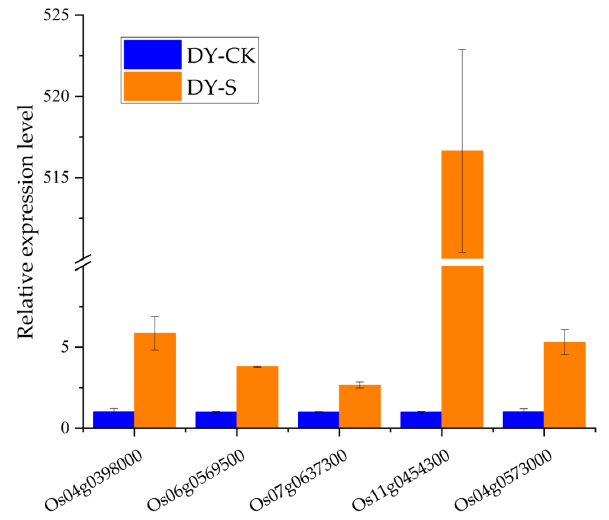
Figure 5. The expression levels of target genes under salt stress detected by qRT-PCR. The blue bars represent the samples under the normal condition, and the orange bars represent the samples under salt stress. The relative expression was calculated by the 2 −ΔΔCt method, and the standard deviation was calculated with three biological repeats.